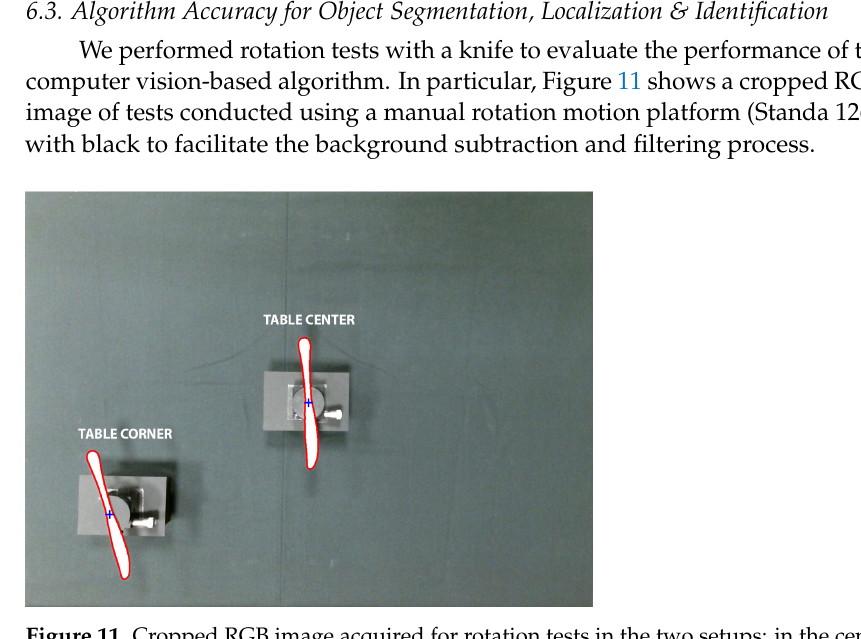
Figure 11. Cropped RGB image acquired for rotation tests in the two setups: in the center of the table and near a corner of the